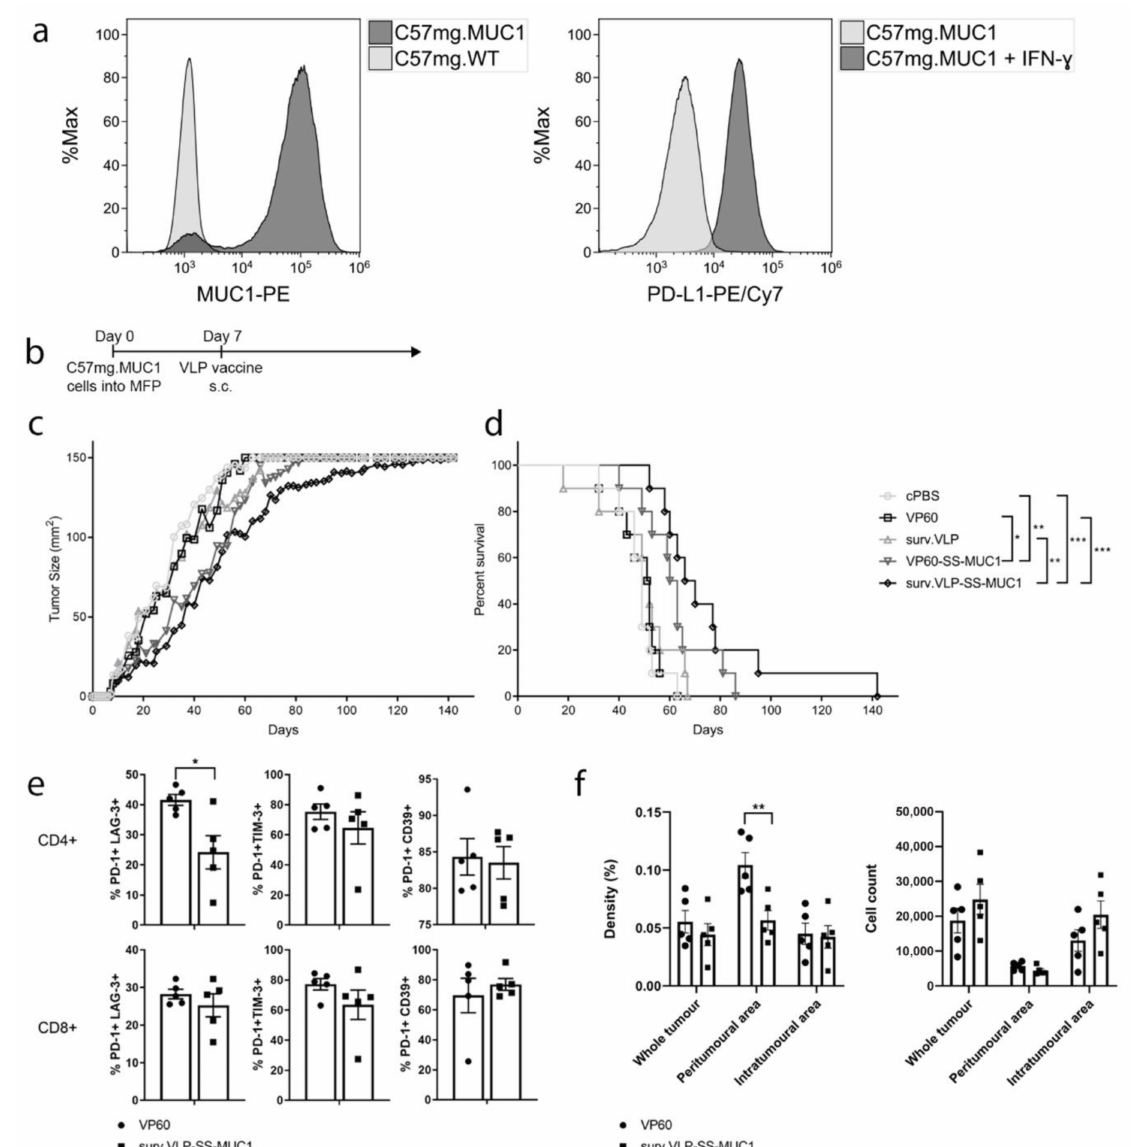
Figure 3. Anti-tumour response of surv.VLP-SS-MUC1 in therapeutic tumour trial. ( a ) Expression of MUC1 and PD-L1 (following IFN-y stimulation) by C57mg.MUC1 cells. ( b ) Timeline of tumour trial. C57/BL6 mice ( n = 10 mice per treatment group) were inoculated with C57mg.MUC1 tumour cells in the mammary fat pad (MFP). Once tumours were palpable (day 7), mice were vaccinated with VLPs delivering one or two antigens or controls. Tumour growth ( c ) and overall survival ( d ) for each treatment group were recorded. Once tumour size reached 150 mm 2 mice were euthanised and tumours analysed for TILs by flow cytometry ( e ) and IHC for CD3 ( f ). Statistical significance was determined by a log-rank (Mantel–Cox) test for survival and Mann–Whitney tests for TIL phenotype and IHC. *** p < 0.001, ** p < 0.01, * p <